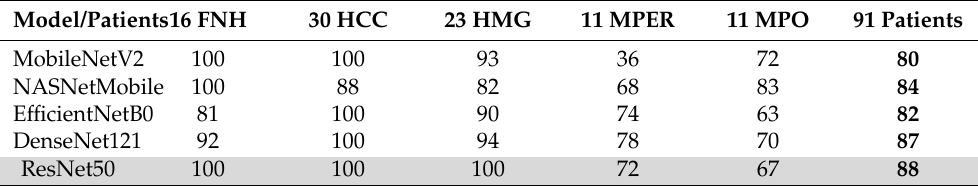
Table 10. Average test accuracy [%]. Modern DNN, hard vote, 40 training epochs, early stopping patience 20, unbalanced number of examples per